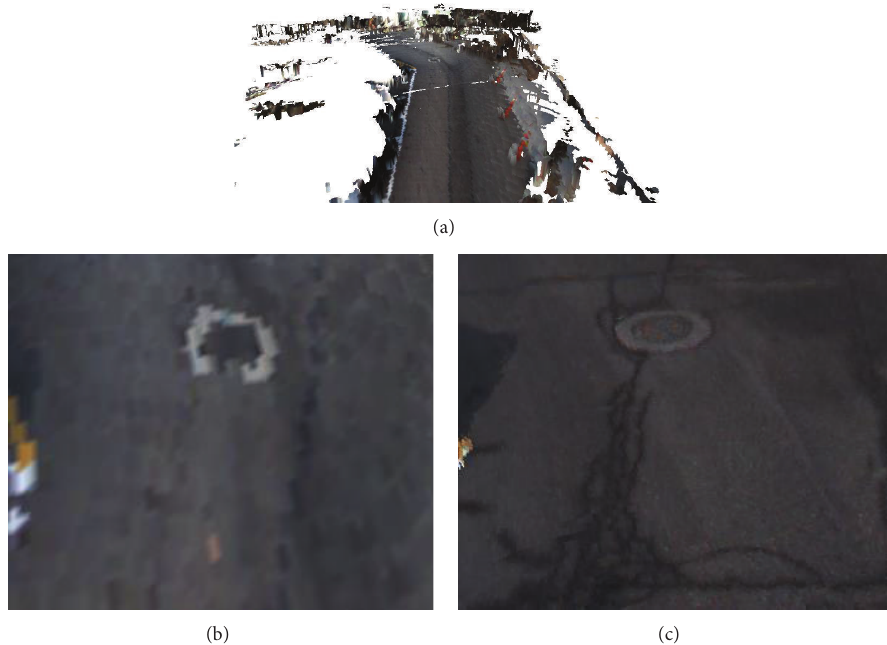
Figure 13: Ground surface representation using a color mesh. (a) A color mesh reconstructed from the segmented ground voxels. (b) A fraction of the color mesh of (a). (c) A fraction of the texture mesh of Figure 12(b).